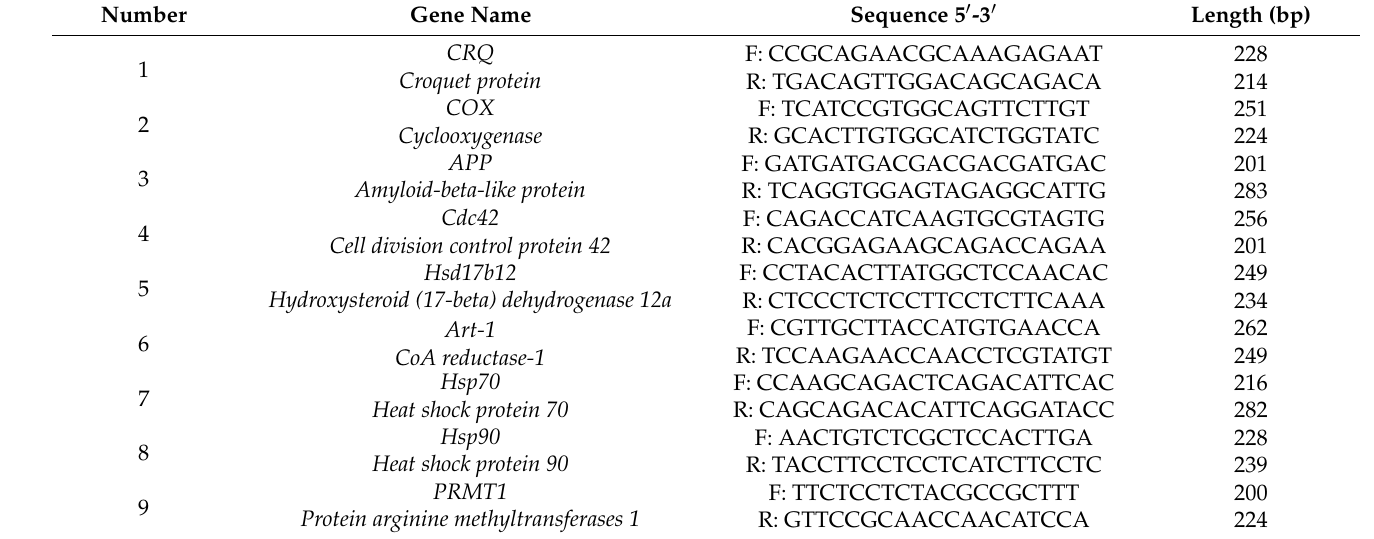
Table 1. Primers used for the RT-qPCR analysis of the gonadal development in Macrobrachium rosenbergii